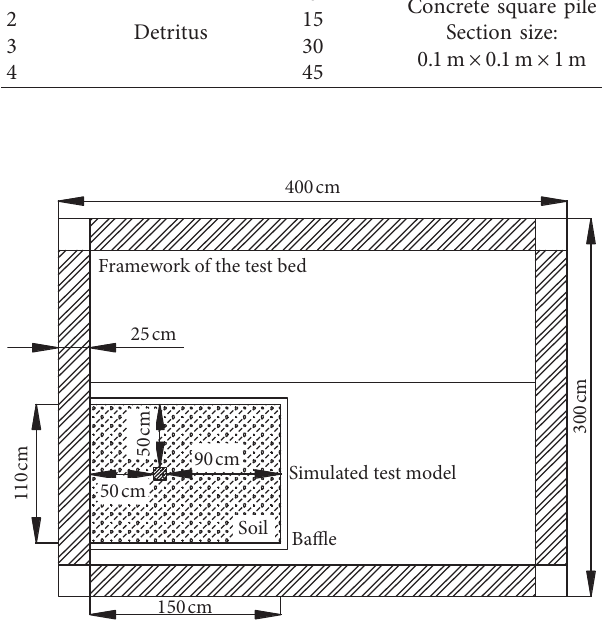
Figure 1: The plane chart of the simulation test.